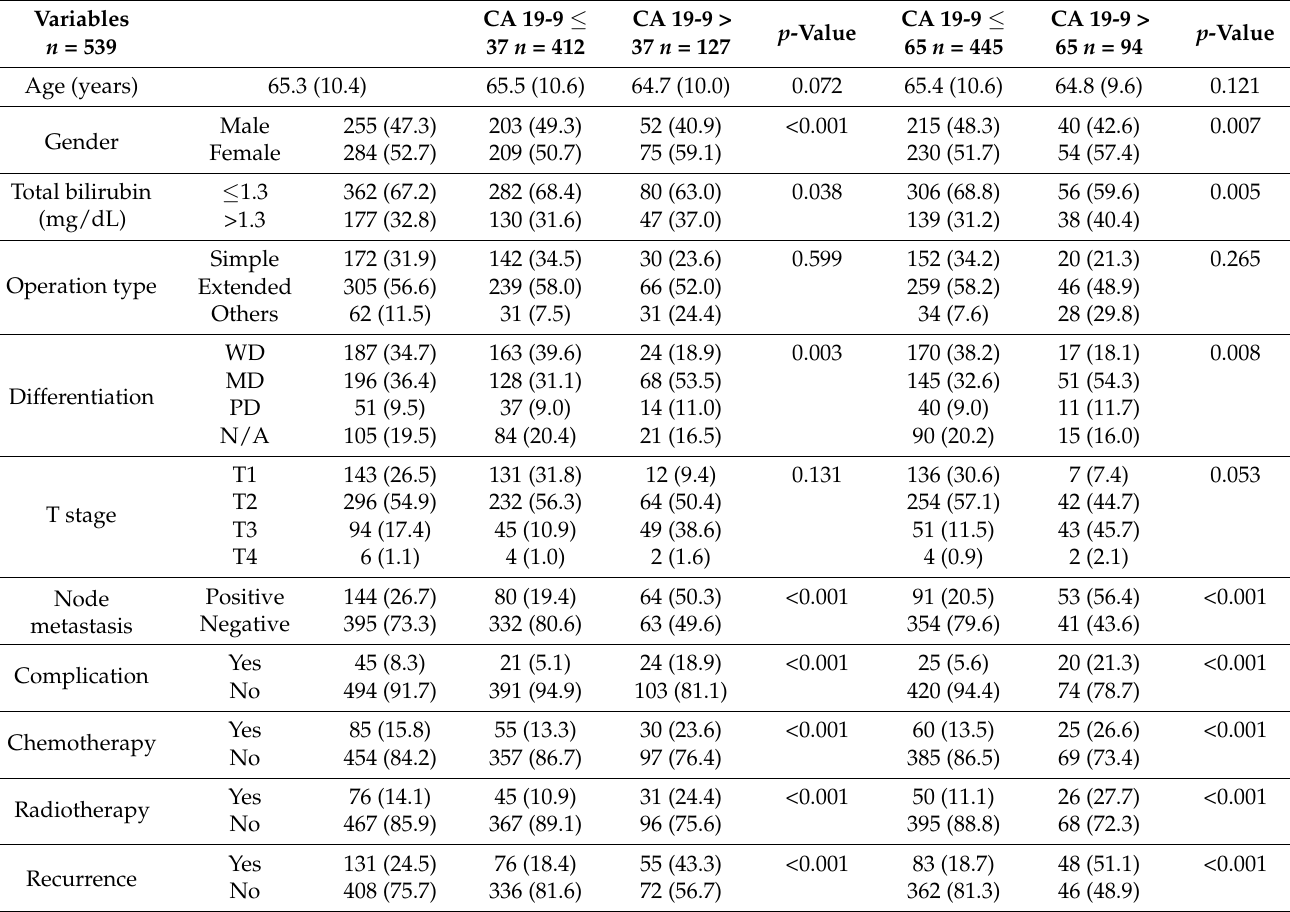
Table 1. Overall patient characteristics ( N =